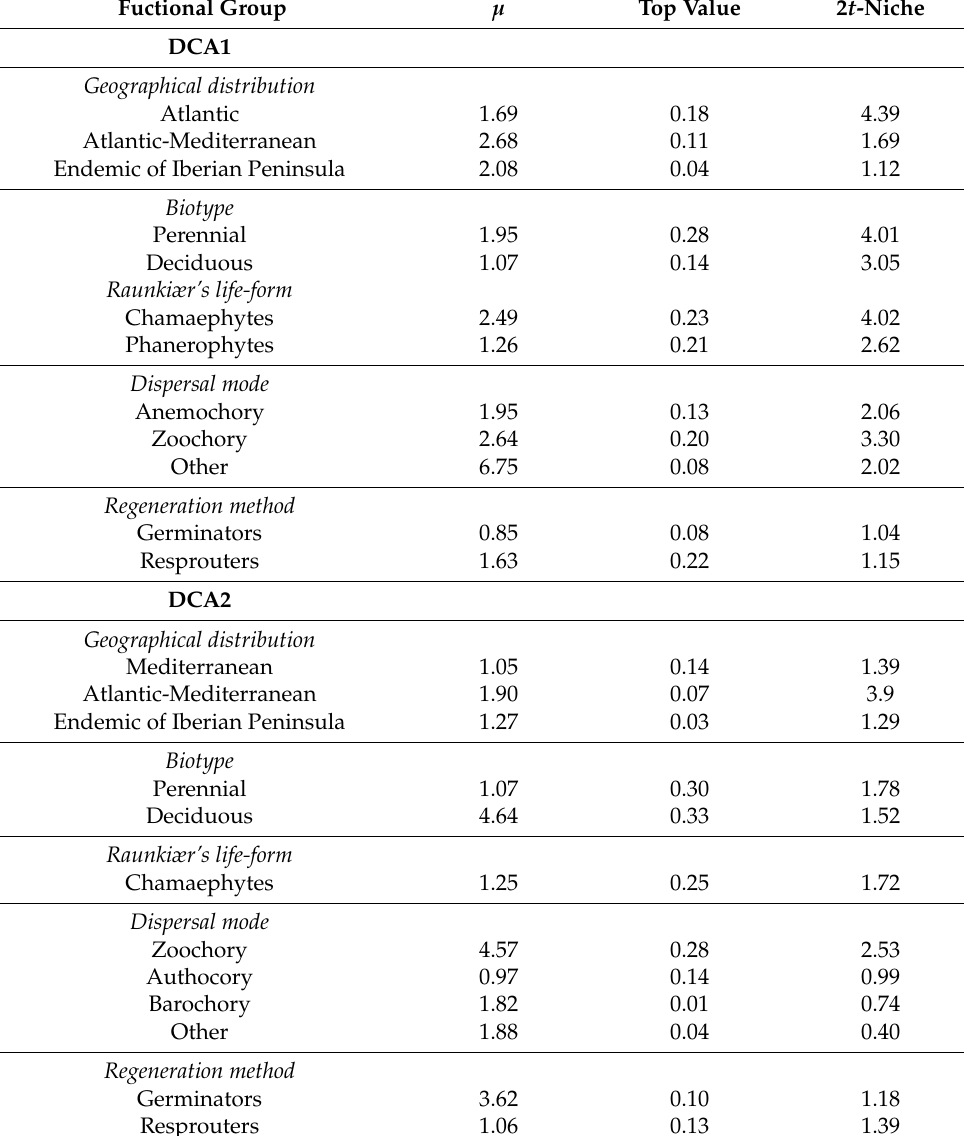
Table 2. Location of optimum ( µ ), top value (predicted maximum probability), and niche widths based on 2 t tolerances for shrub functional groups with unimodal responses (HOF model V; only HOF model IV for ‘authocory’ along DCA1 and ‘Atlantic-Mediterranean’ along DCA2). Data of Atlantic shrubs along DCA2 are not available since their optima fall outside the sampled part of the gradient. Fuctional Group µ Top Value 2 t -Niche